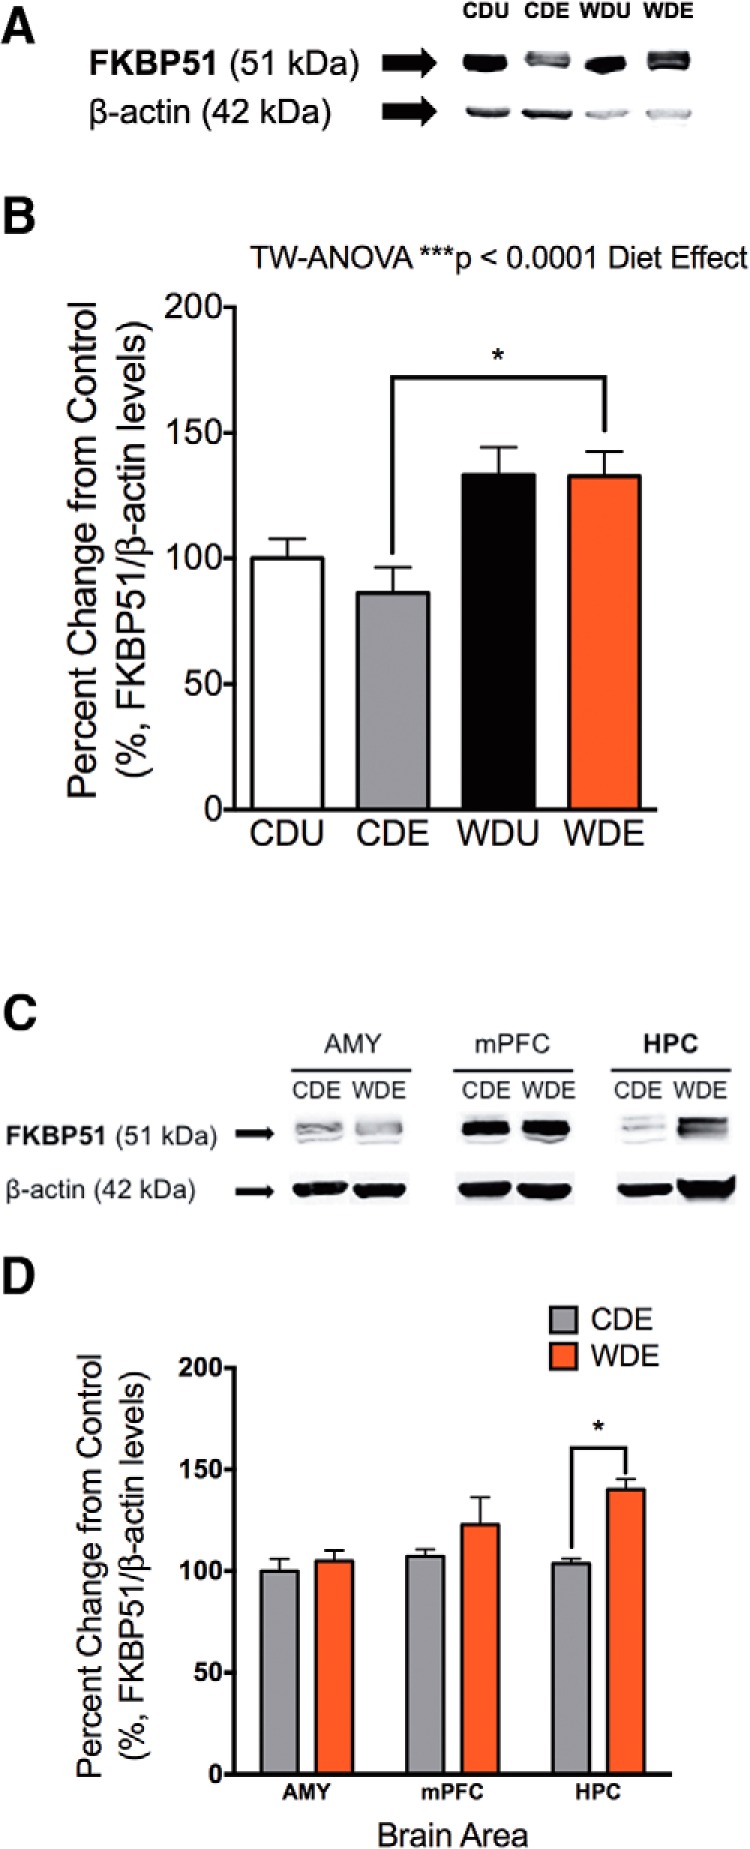
WD increases FKBP51 protein levels in the hippocampus. A, Representative Western blot shows increased FKBP51 levels in the brains of the rats that consumed the WD. B, Analyses showed a significant main effect of the diet on brain FKBP51 levels (diet effect: F(1,19) = 15.45, p = 0.0009), PS exposure (F(1,19) = 0.51, p = 0.49), or interaction between diet and PS exposure (F(1,19) = 0.42, p = 0.52) did not show significant main effects on FKBP51 levels. C, Representative blot from micropunched anxiety-related brain regions showed distinctive FKBP51 levels. D, Analyses revealed a significant increase in FKBP51 levels in the hippocampus of the WDE rats when compared with CDE rats (F(1,16) = 9.88; p = 0.0063, p = 0.021). Diet did not alter FKBP51 levels in the amygdala or medial prefrontal cortex. Although it did not reach statistical significance, we found a trend for more prefrontal cortex FKBP51 levels when compared with the amygdala and the hippocampus (F(2,16) = 3.58, p = 0.052). No significant interactions between diet and the studied brain regions were revealed (F(2,16) = 2.44, p = 0.12). Data are expressed as the mean ± SEM. *p < 0.05. Amygdala (AMY), n = 3–4 rats; medial prefrontal cortex (mPFC), n = 3–4; HPC, n = 4–5.